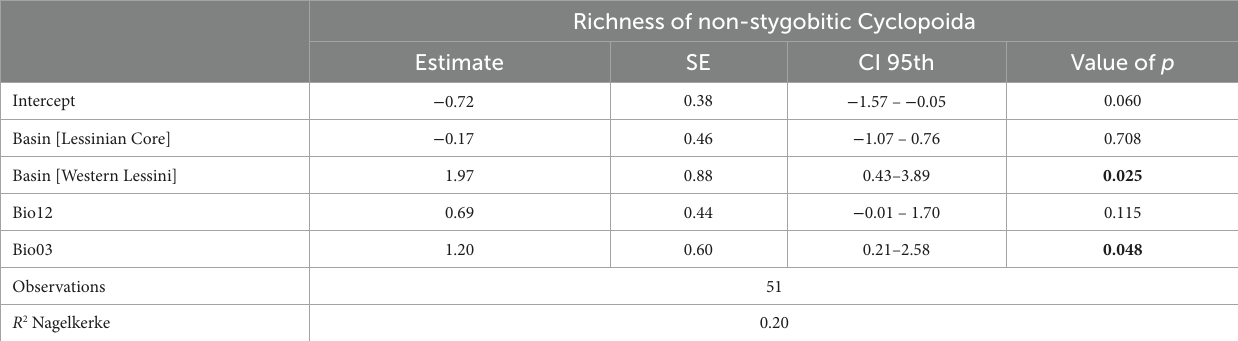
TABLE 4 Results from the refined Generalized Linear Model relating species richness of non-stygobitic Cyclopoida to the drainage basin the sampled caves belong to, isothermality (Bio03) and annual precipitation (Bio12).